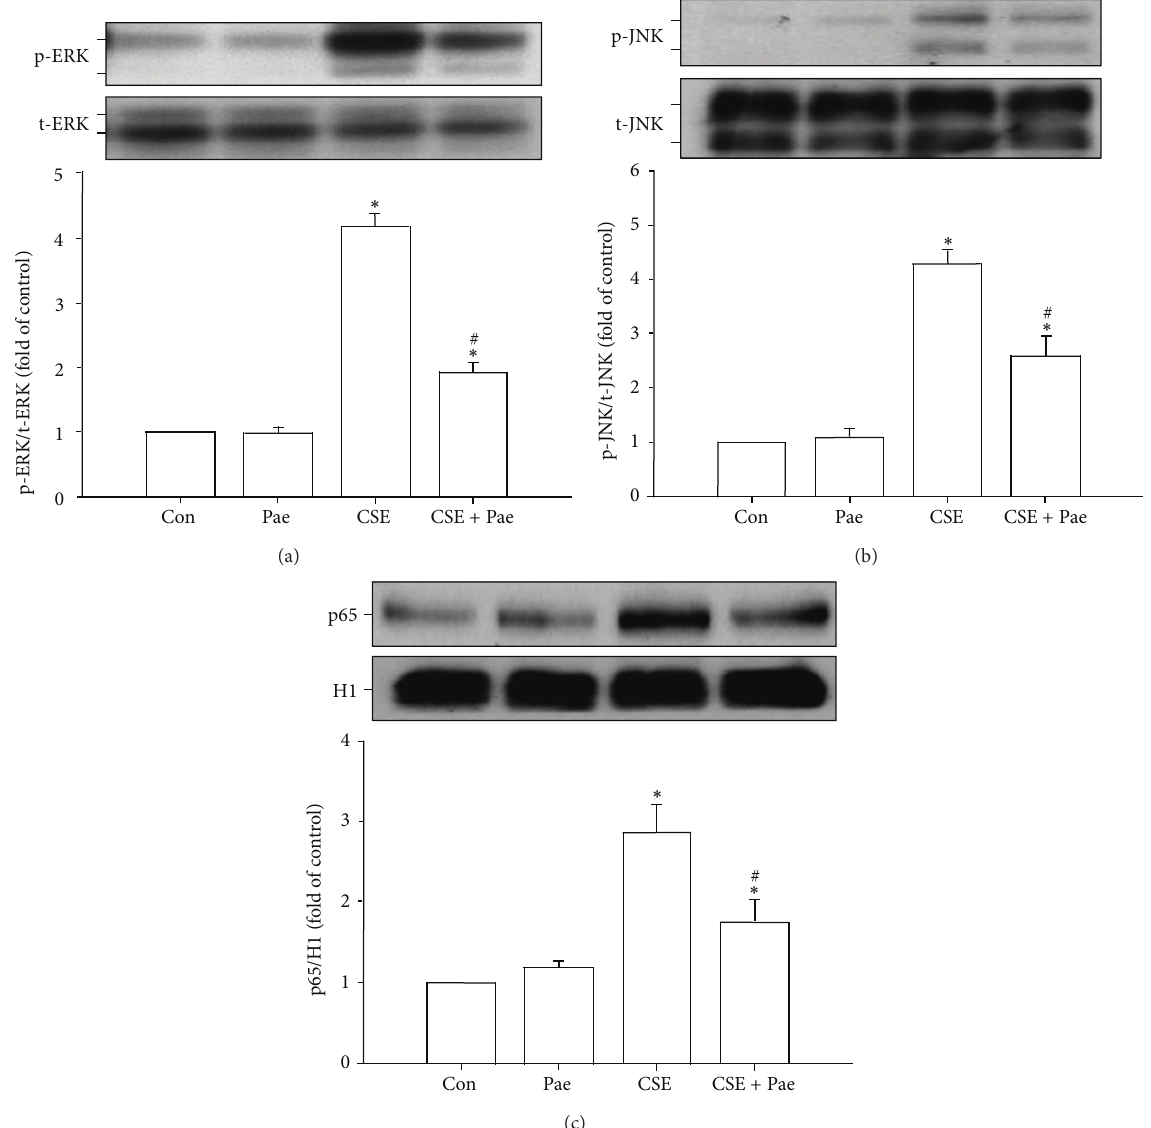
Figure 8: Paeonol (Pae) attenuates the activation of ERK, JNK, and NF- 𝜅 B signaling by cigarette smoke extract (CSE) in human bronchial epithelial cells. Cells were exposed to medium alone or 3% CSE for 6 ((a), (b)) or 12 hours (c) with pretreatment with Pae (0.4 mM) or the vehicle of Pae. Protein expression was analyzed by Western blotting. ∗ 𝑃 < 0.05 versus control. # 𝑃 < 0.05 versus CSE without Pae